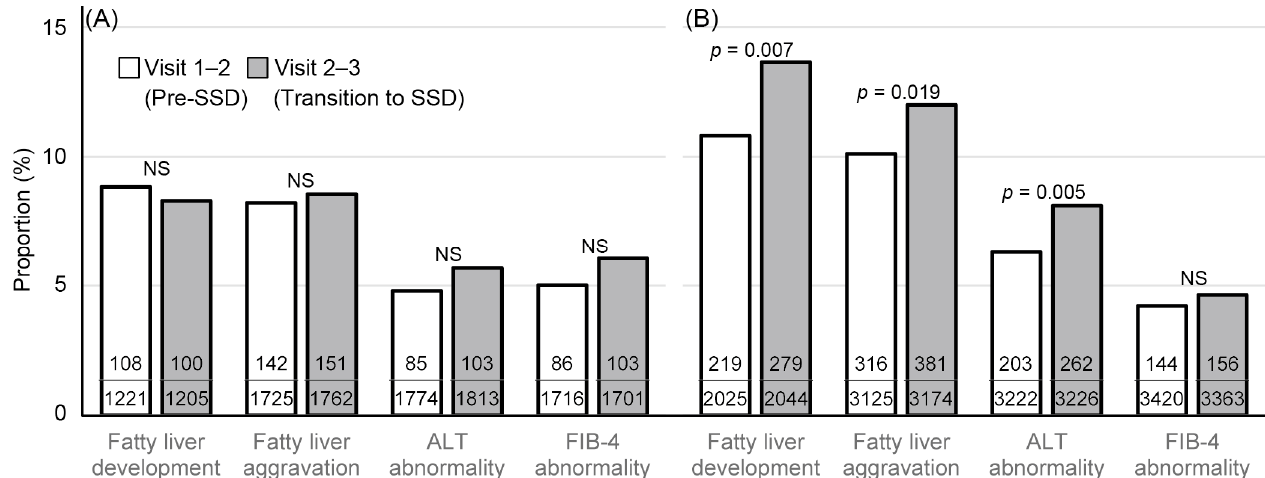
Figure 3. Fatty liver change comparison between the SSD transition and pre-SSD periods in ( A ) the non-drinker and ( B ) alcohol consumption groups. The proportions were compared using the chi-squared test. NS: not significant.